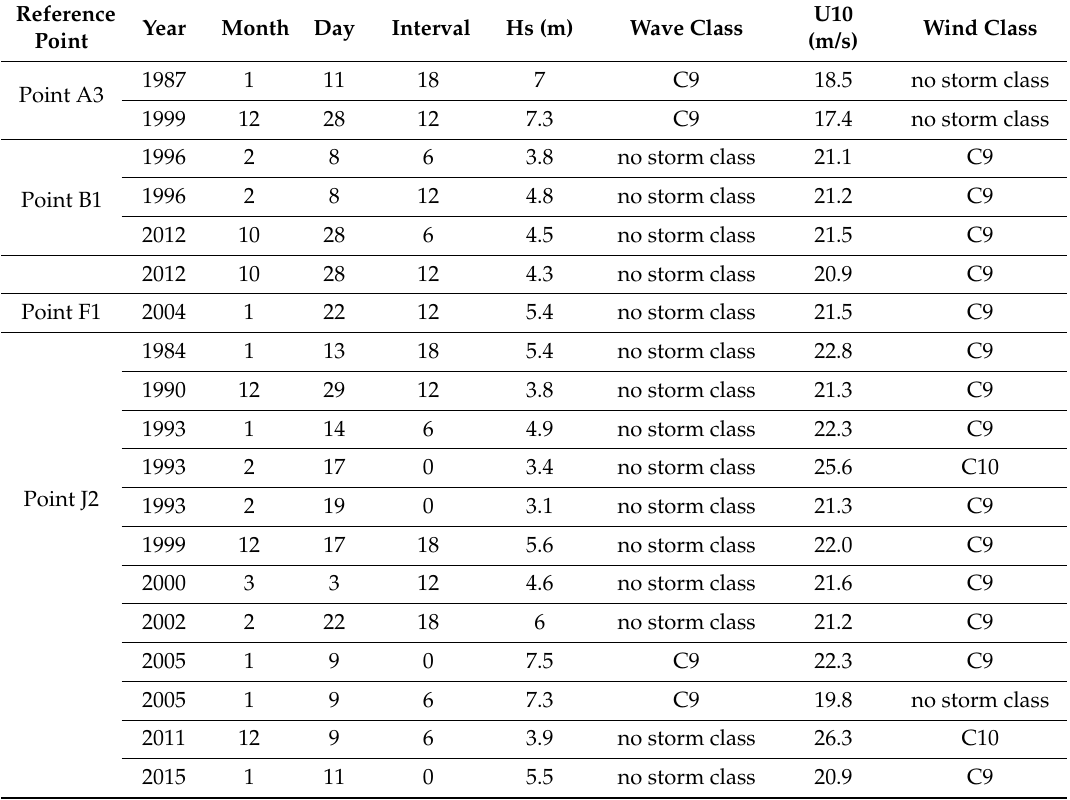
Table 7. Maximum wind and wave conditions according to the Beaufort scale for the Mediterranean, Black, and Baltic seas.